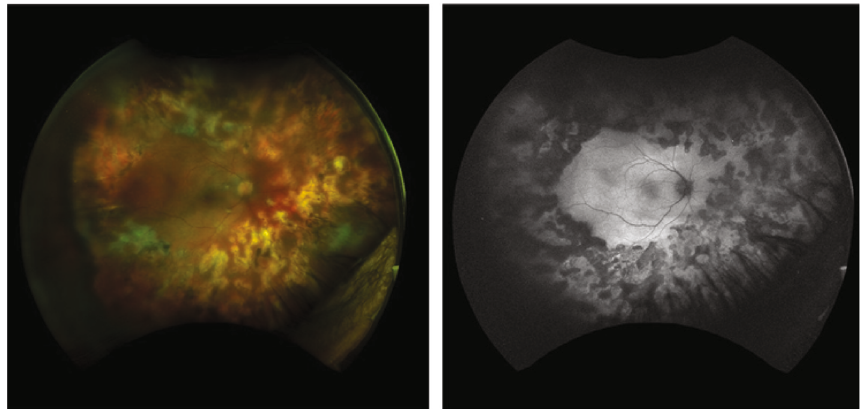
Figure 4: Wide-angle fundus photograph and fundus auto fl uorescence (FAF) images (Optos PLC, Dunfermline, UK). The laser photocoagulation therapy was e ff ective, and no pathology was observed in the retina.